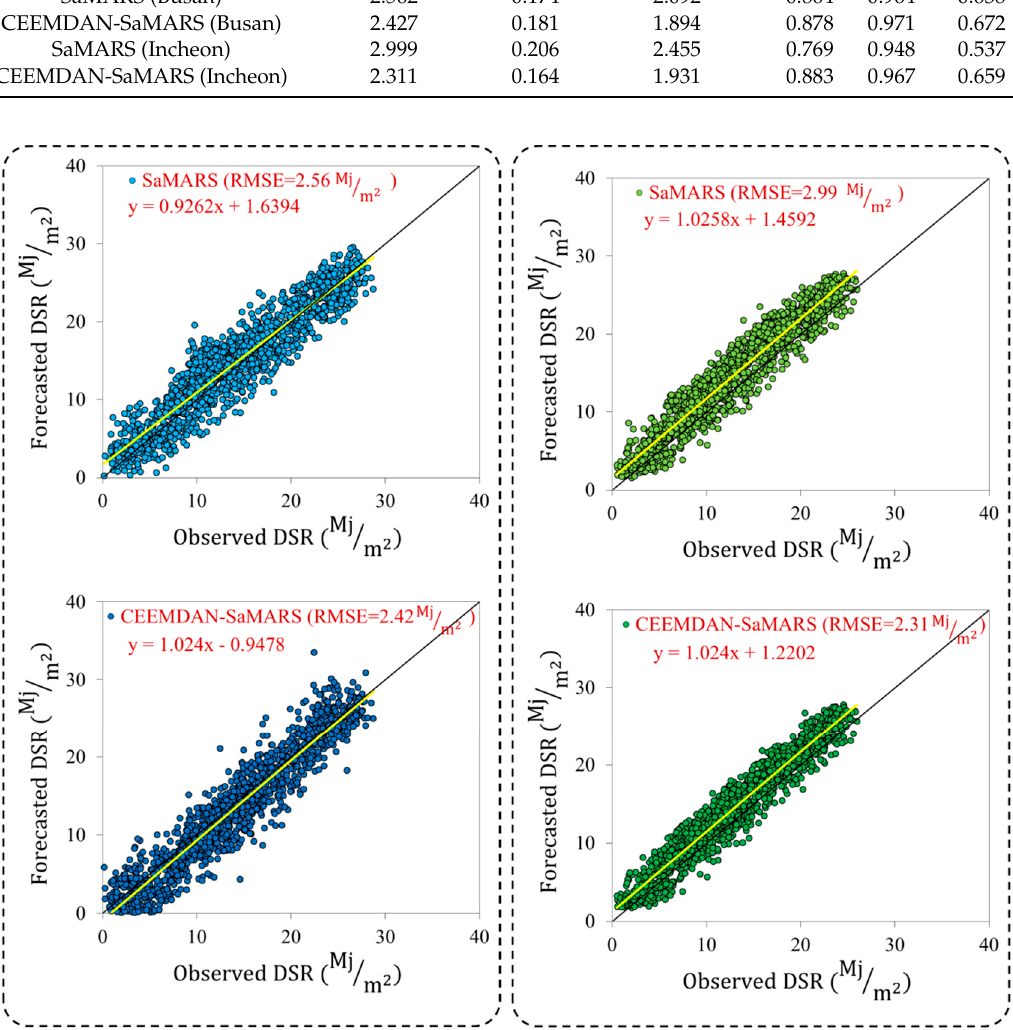
Figure 8. Scatterplots of observed and forecasted DSR using the SaMARS and CEEMDAN-SaMARS models in the validation phase at Busan (blue color) and Incheon (Green color) stations.